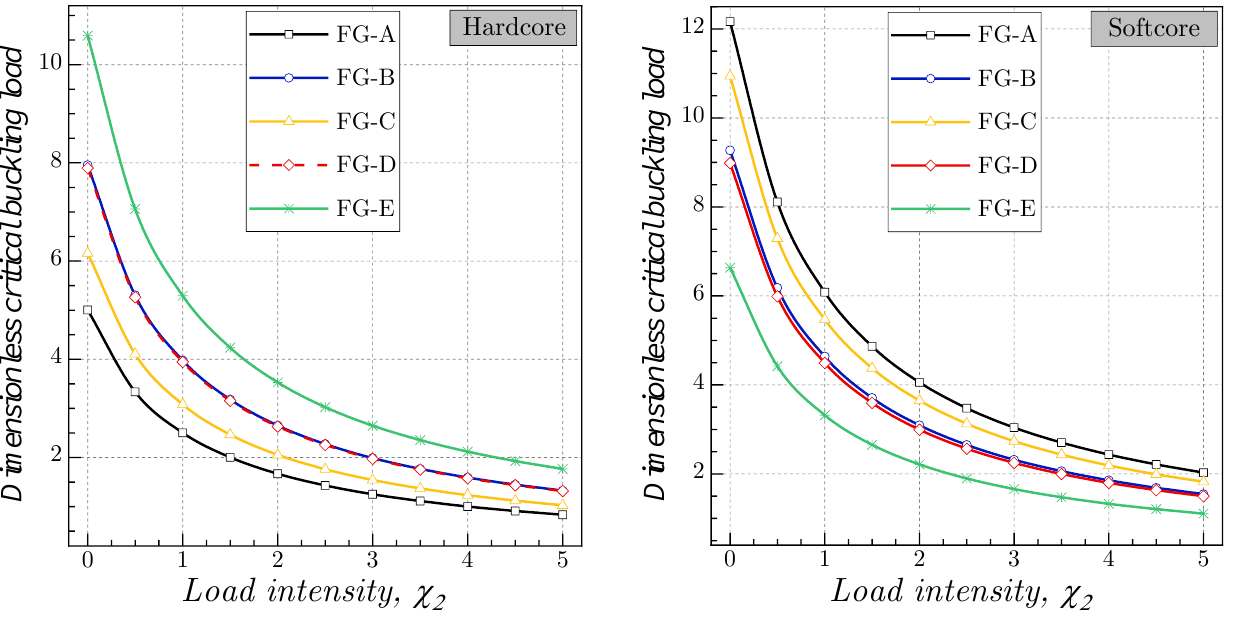
(cid:1) . = 𝐺 = 𝐾 = 0) . 𝜁 𝜂 𝑤